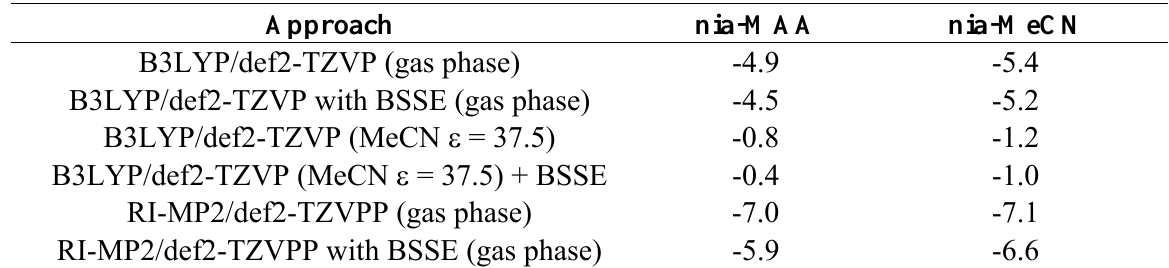
Table 6. The binding energy (in kcal/mol) of the hydrogen bond of 3 and the hydrogen bond between nia and MeCN for various theoretical approaches in comparison.